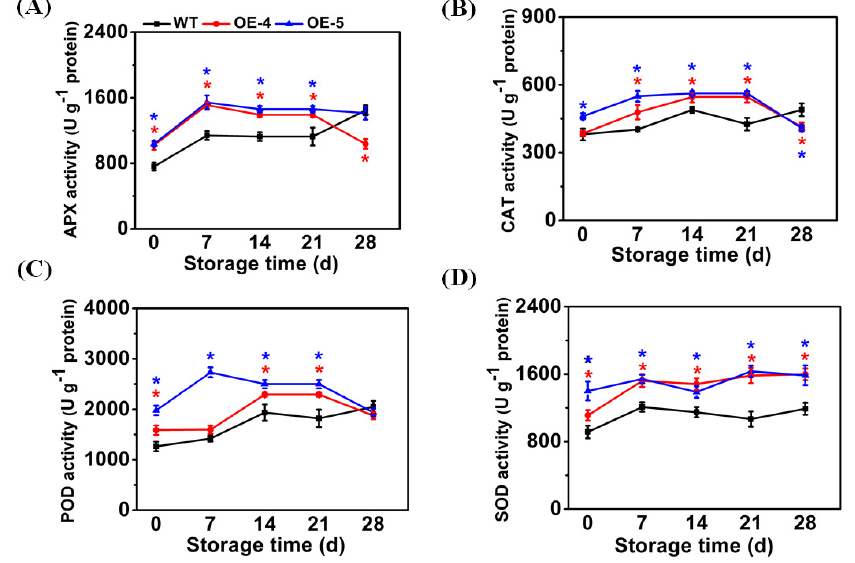
Figure 3. SlCYP90B3 overexpression increased the antioxidant enzymes activities in tomato fruits during 28 days of cold storage. ( A ) APX, ( B ) CAT, ( C ) POD, and ( D ) SOD. Each data point is mean ± SE ( n = 3).